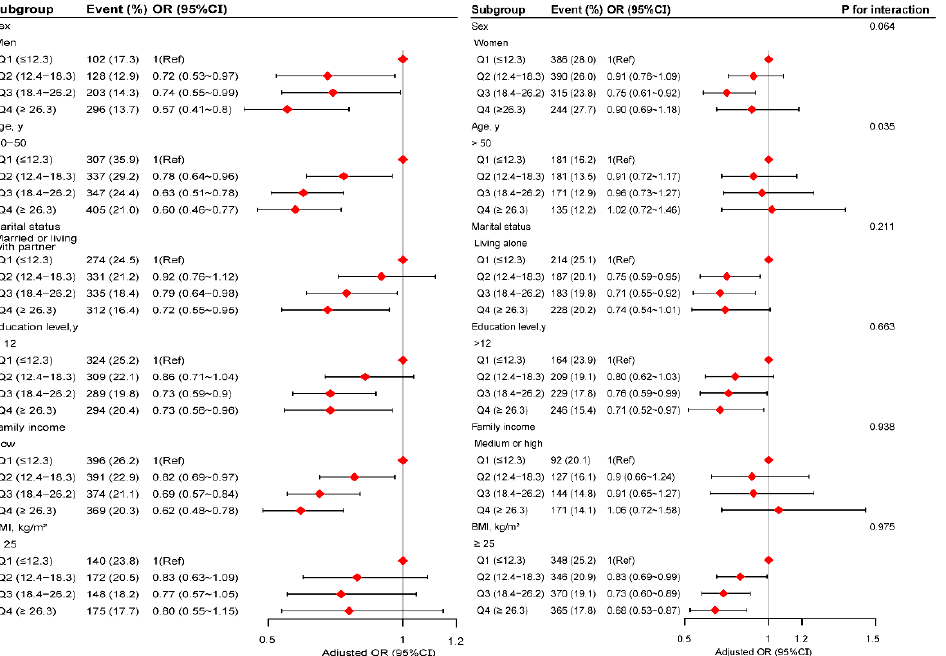
Figure 3. The relationship between dietary niacin intake and migraine according to basic features. Except for the stratification component itself, each stratification factor was adjusted for all other variables (age, sex, marital status, race/ethnicity, education level, family income, smoking status, physical activity, hypertension, diabetes, stroke, coronary heart disease, body mass index, energy consumption, protein consumption, carbohydrate consumption, fat consumption, dietary supplements taken, and C-reactive protein).